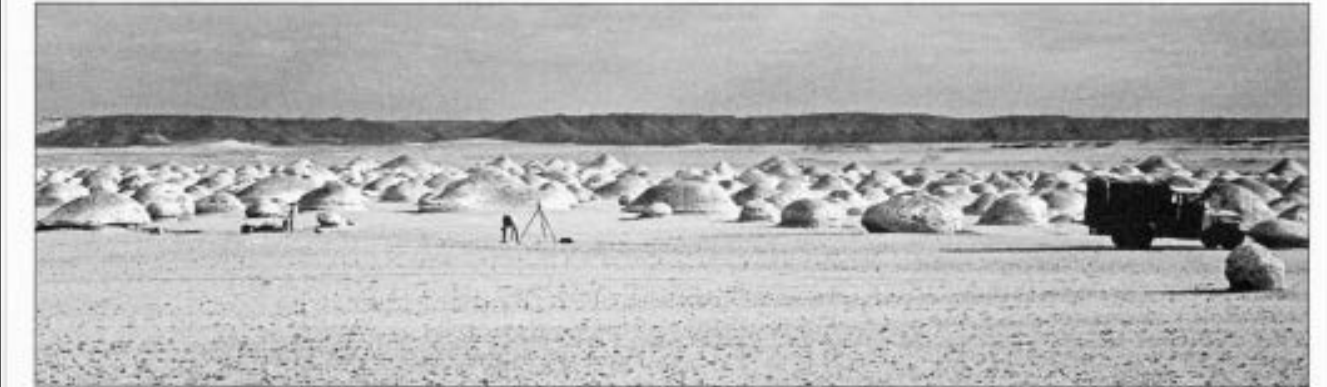
Figure 2 Wetter conditions during the Holocene are indicated by the remains of ephemeral lakes (playas) that dot the depressions of the Western Desert. Bahr Playa (shown here) is one of the principal playas in the Farafra depression and has revealed evidence of human occupation. The rounded hillocks are erosional remnants of ancient lake